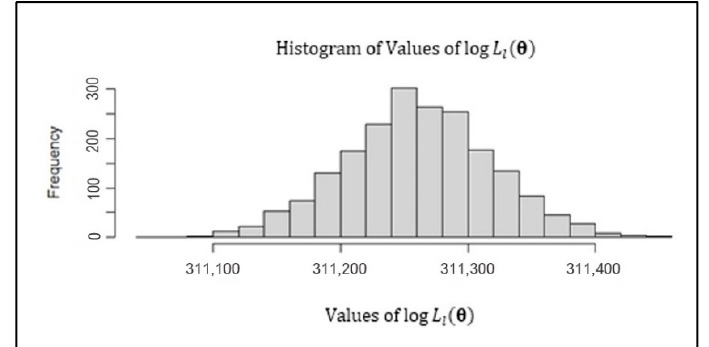
Figure 5. Histogram of values of log L l ( θ ) for 𝓀 = 2000. Next, as an illustration, the values of log L l ( θ ) , where m = 260, n = 1, 738, 665, l = 30, for 𝓀 = 1000, are shown in Figure 6.